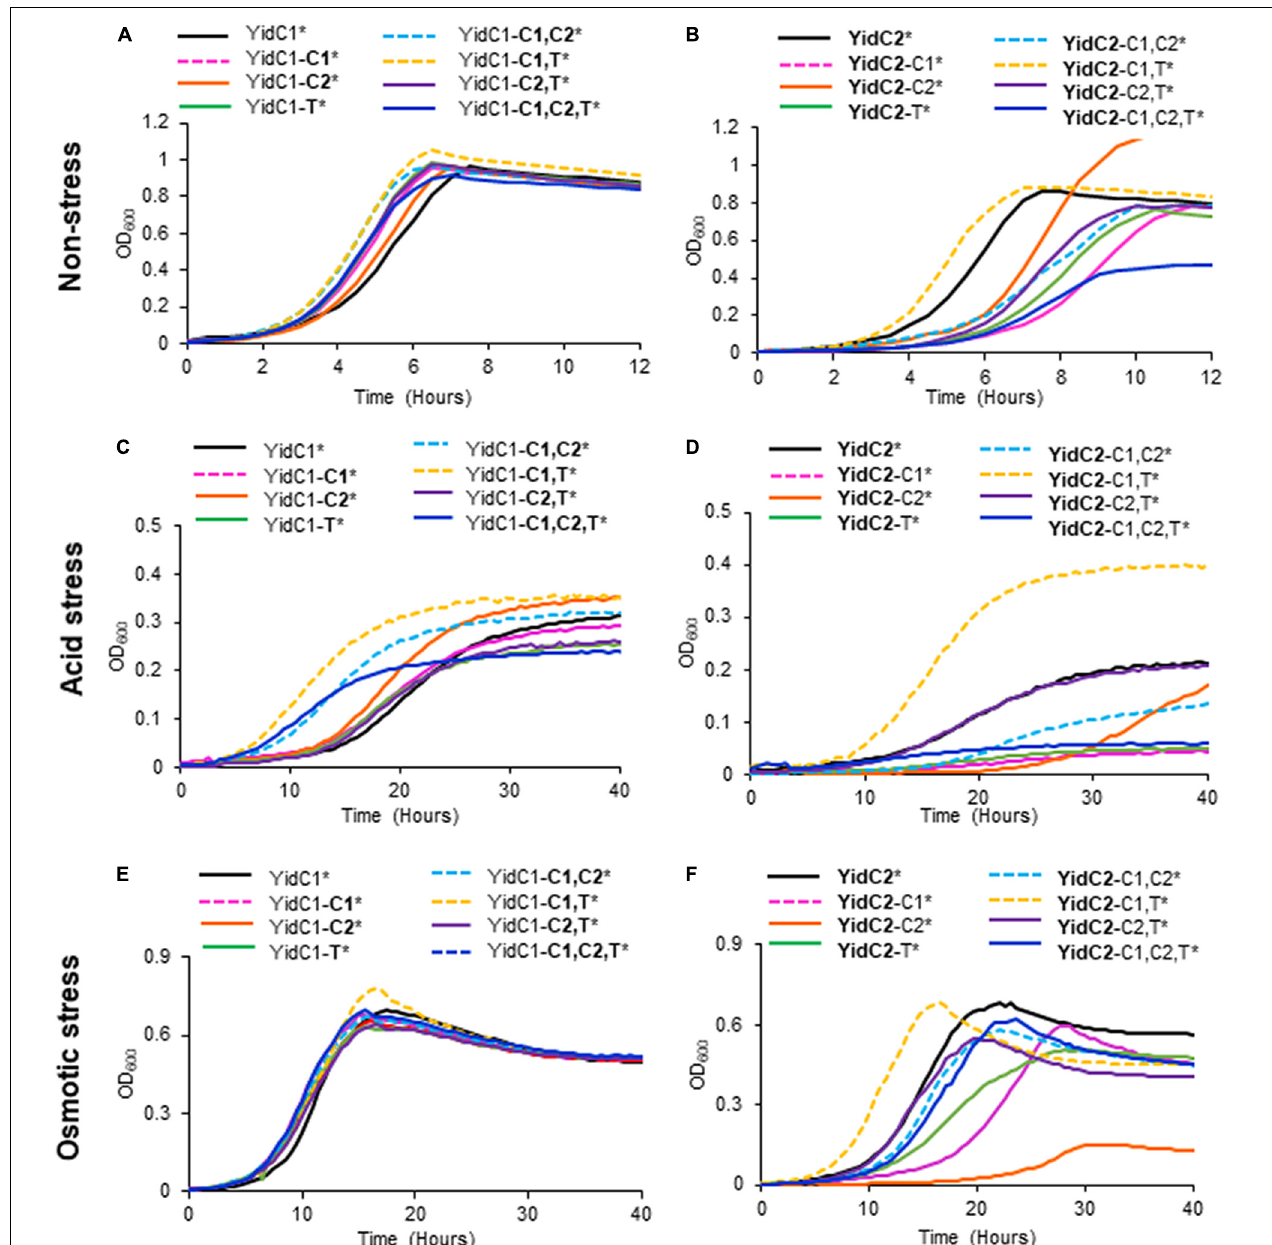
FIGURE 4 | Effect of YidC1/2 cytoplasmic domain substitutions on S. mutans growth under non-stress, acid-stress, or salt-stress conditions. Growth of strains complemented by ectopic expression (*) from the gtfA locus of unmodified yidC1 (A,C,E) or yidC2 (B,D,F) compared to corresponding cytoplasmic domain (CD) swap variants in a double (cid:49) yidC1/ (cid:49) yidC2 background. (A,B) Growth in THYE, pH 7). (C,D) Growth in THYE acidified to pH 5.0. (E,F) Growth in THYE supplemented with 3% NaCl. Growth measurements were carried out at least three times with each sample assayed in triplicate. Data shown are mean replicates of an independent experiment. Regular text indicates YidC1 backbone or CD. Bold text indicates YidC2 backbone or